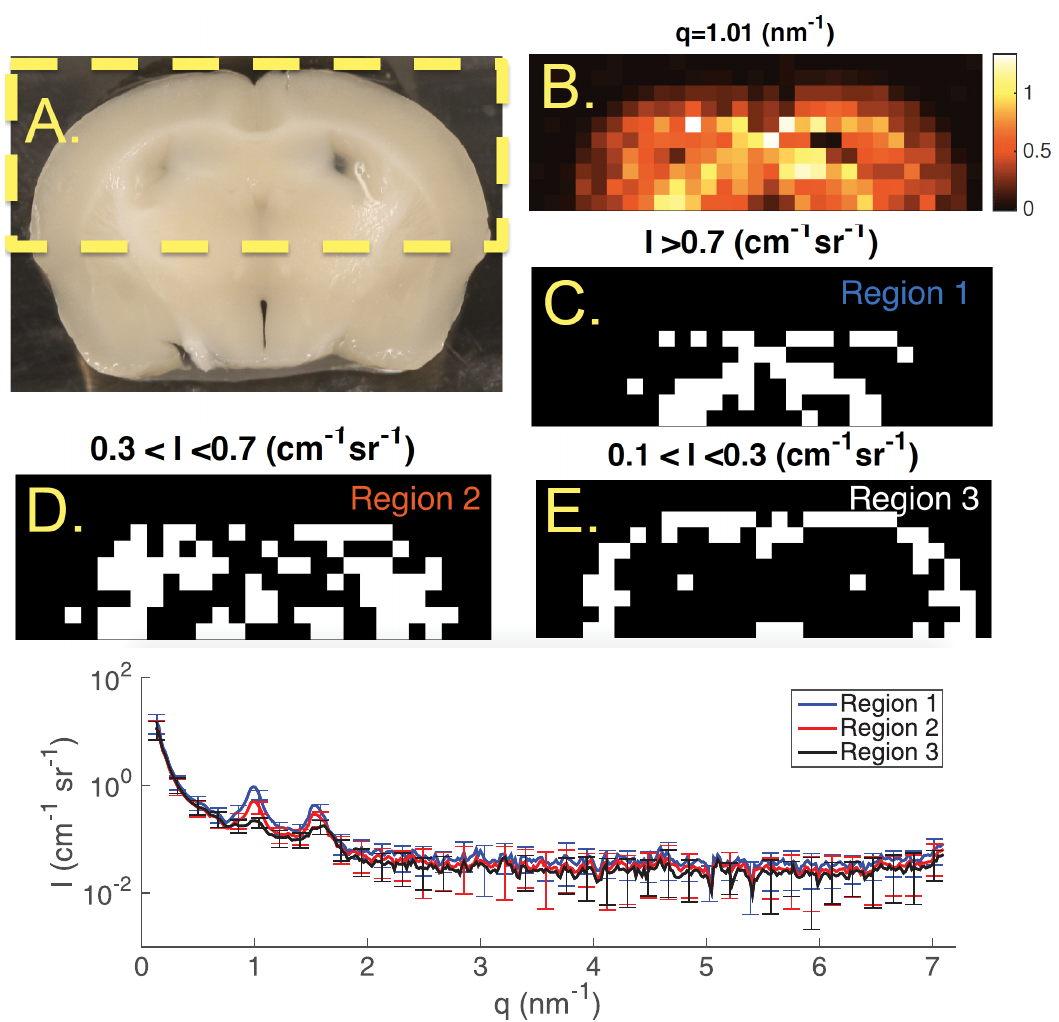
Fig 6. (A.) Photographof a coronal slice in a second mouse brain. Dotted yellow line indicatesregion that was imaged. (B.) An intensity map at q = 1.01 nm − 1 where the first peak appearedin the scatter profiles. (C.) First regionwhere intensity was higherthan 0.7 cm − 1 sr − 1 in B. (D.) Second regionwhere the intensity was between0.3 and 0.7 cm − 1 sr − 1 in B. (E.) Third regionwhere the intensity was between0.1 and 0.3 cm − 1 sr − 1 in B.(Bottom) Scatter profiles of the averageof pixels in the three regions depicted in C,D and E. Error bars are ± σ of the pixels in each region. They are plotted every 10 points for clarity.